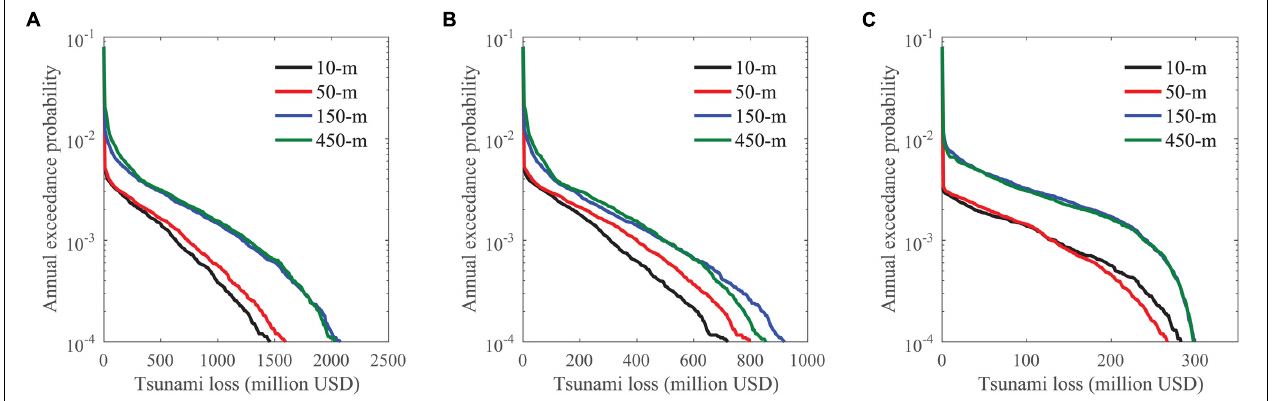
FIGURE 7 | Tsunami loss curves in Sendai: (A) whole Sendai, (B) PR1, and (C) PR2.